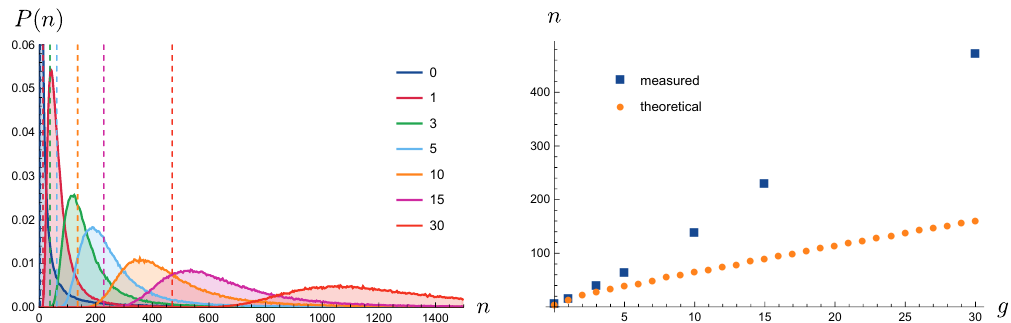
Figure 11. Histograms of slice volumes (left) and minimal slice sizes (right) in the type III CDT ensemble with T = 10 time slices and system volume ˜ N 31 = 20000 , for distinct values of the spatial genus g ∈ { 0 , 1 , 3 , 5 , 10 , 15 , 30 } . The vertical dashed lines in the histogram plot indicate the minimal slice sizes for each value of g . The dashed line in the rightmost plot shows the theoretical lower bound δ ( T g ) for the number of triangles required to triangulate an oriented genus- g surface. Note: the distribution for g = 0 peaks near 0 . 26 and is partially cut off from the